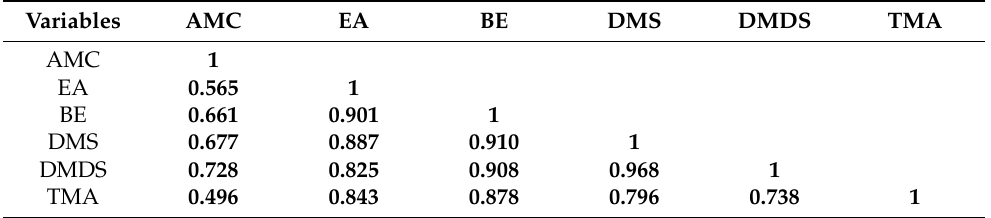
Table 4. Pearson’s correlation coefficient matrix between aerobic mesophilic counts selected spoilage quality indicators measured in Cape hake fillets during